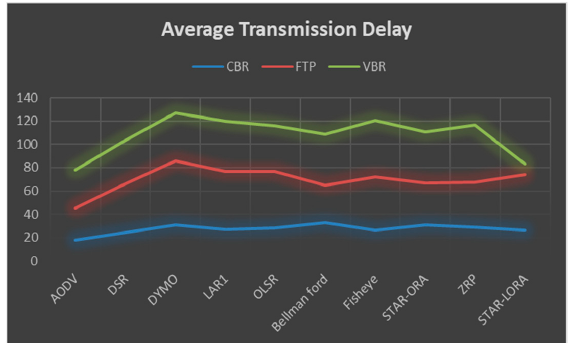
Figure 16. Average transmission delay of all routing protocols for 60 nodes .